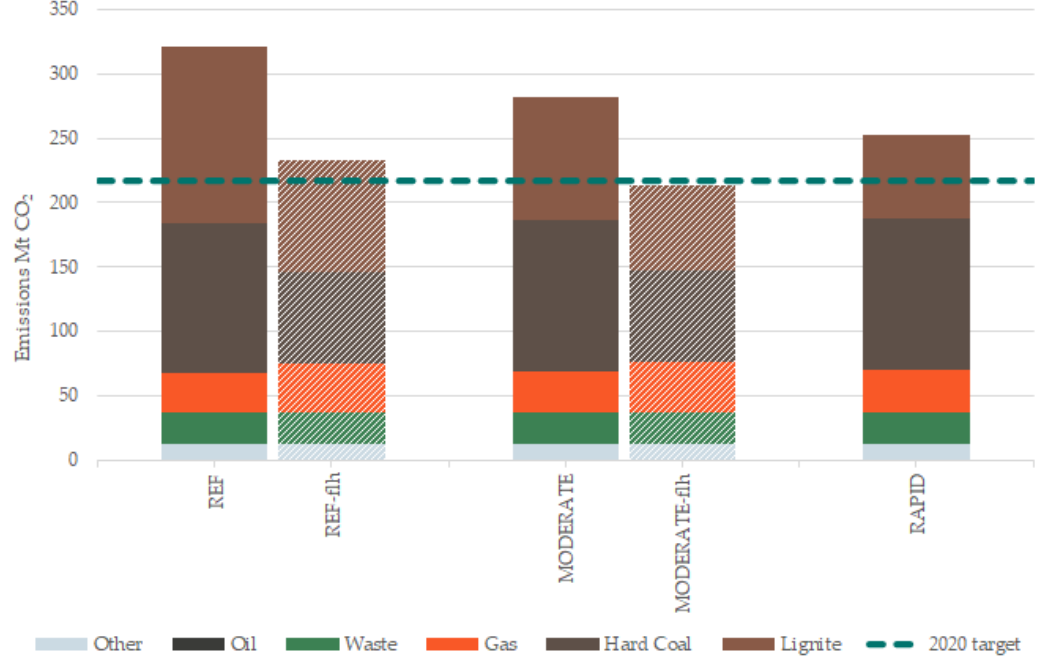
Figure 4. Emissions of the German electricity sector in 2020 (own calculations).